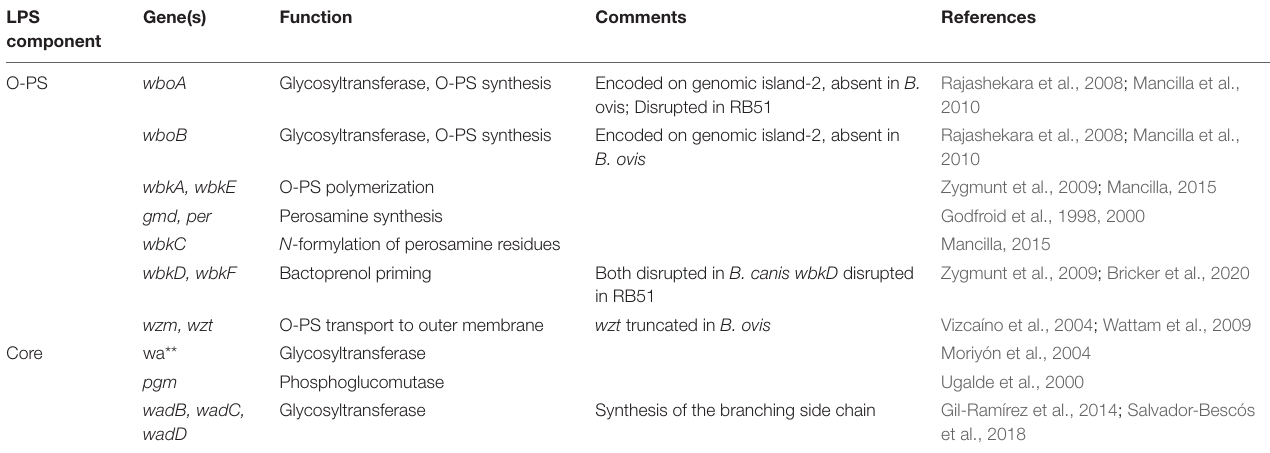
TABLE 1 | Genes involved in the synthesis of the core oligosaccharide and O-polysaccharide in Brucella